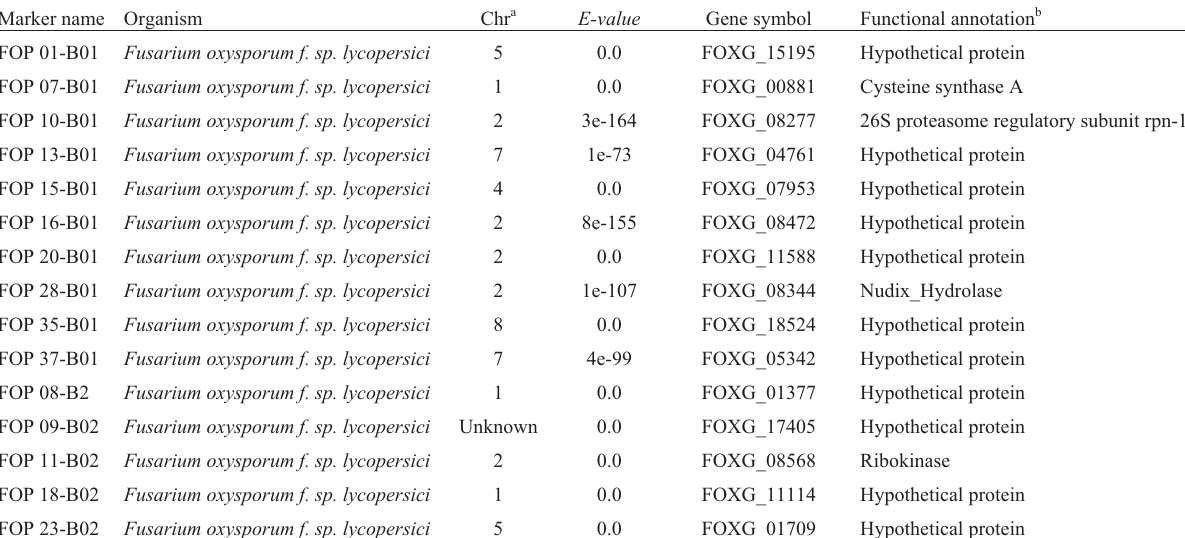
Table 5 - Annotation of the SSRs on Fusarium oxysporum f. sp. phaseoli